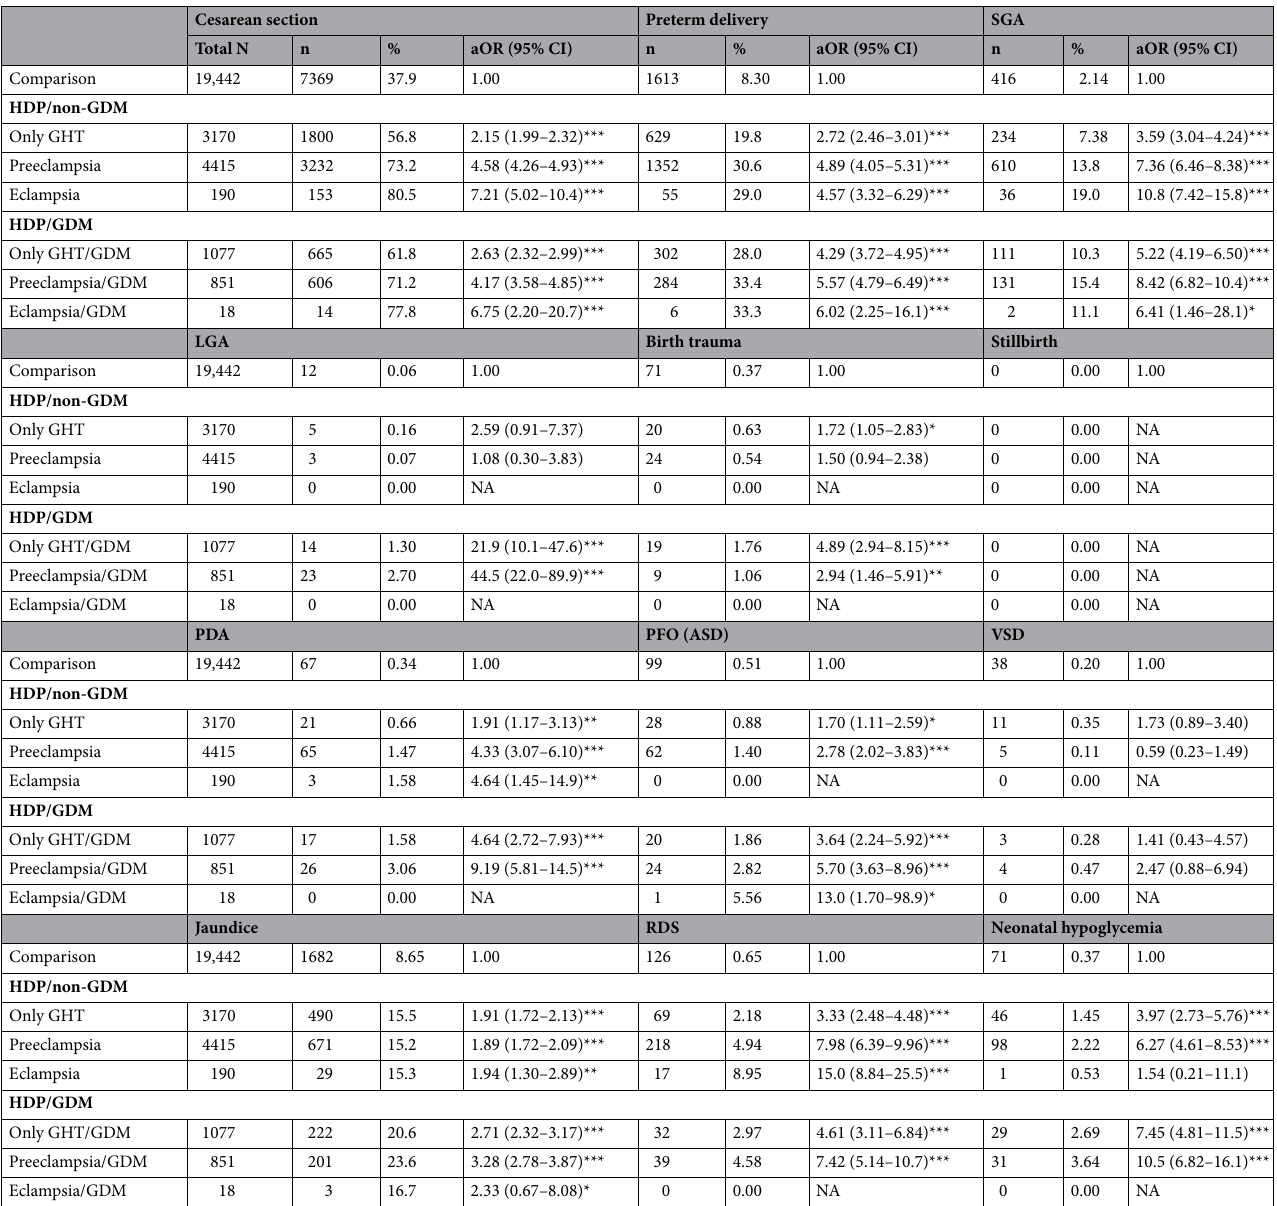
Table 3. Comparison in obstetric and adverse neonatal outcomes associated with preeclampsia/eclampsia in women with hypertension during pregnancy (HDP) with and without gestational diabetes mellitus (GDM). aOR: adjusted odds ratio after controlling for age, urbanization level, renal disease and obseity; HDP: hypertension during pregnancy; GHT: gestational hypertension; non-GDM: no gestational diabetes mellitus. SGA, small gestation age; LGA, large gestation age; PDA, patent ductus arteriosus; PFO, foramen ovale/ atrial septal defect; VSD, ventricular septal defect; RDS, respiratory distress syndrome. *p < 0.05, **p <